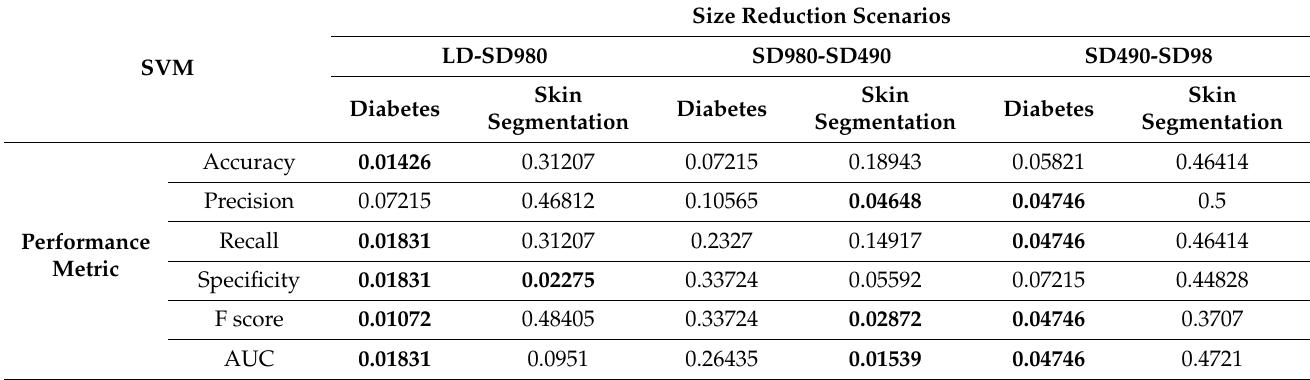
Table A6. p -values for different size reduction scenarios using the SVM model; bold values are significant.